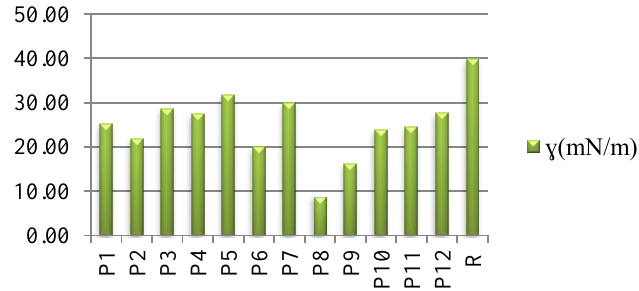
Figure 14. Interfacial tension of wool fabrics, dyed (P1 – P12) and raw (R).